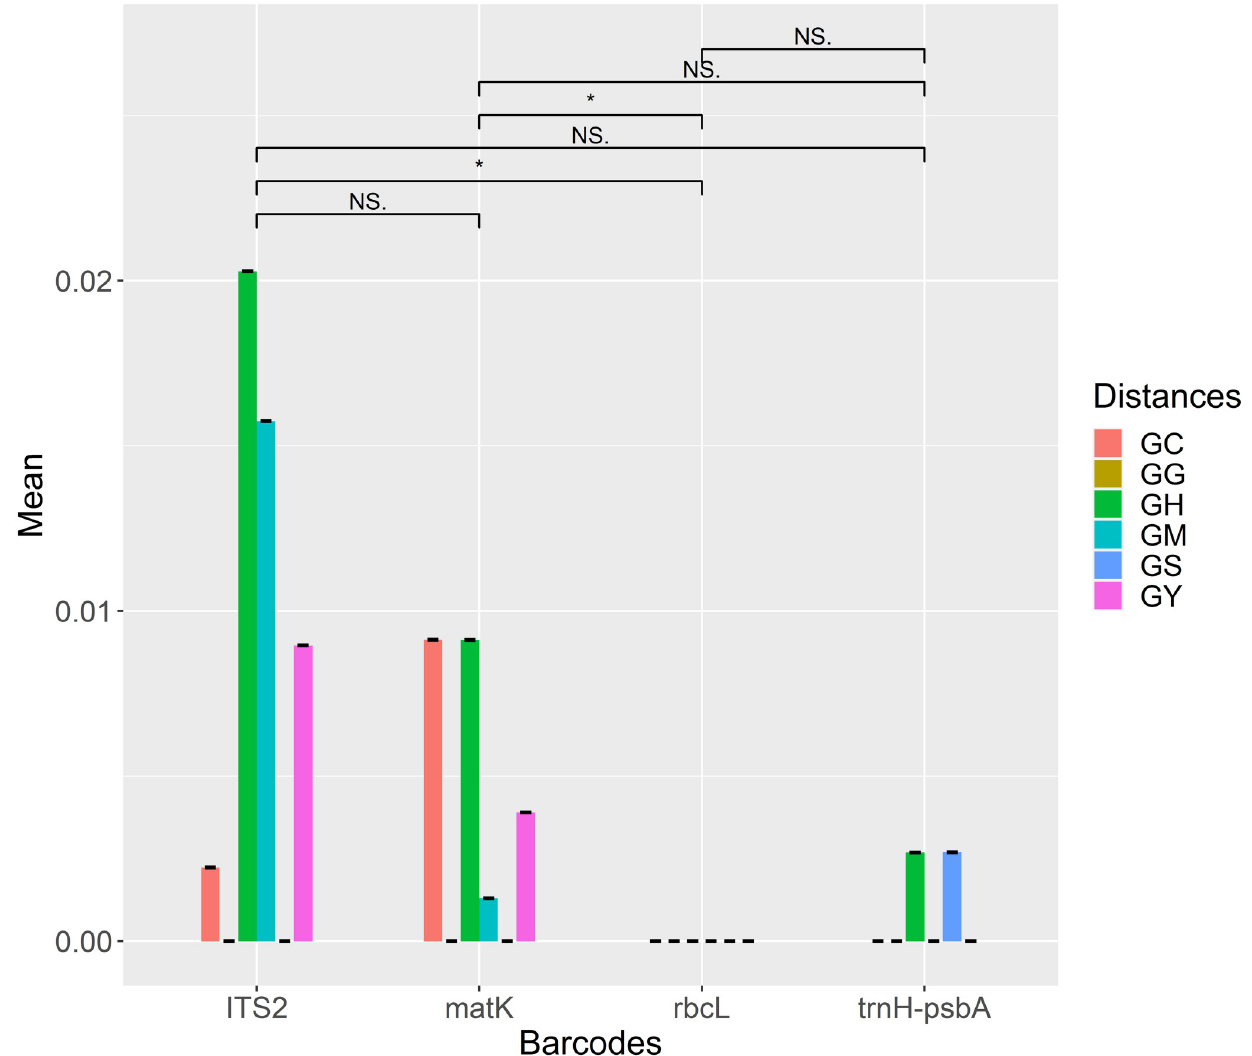
Fig 3. Genetic distances between 58 Qi-Nan germplasms and the Aquilaria species for a single region. ( GC : interspecific distance between the Qi-Nan germplasm and A . crassna . GG : intraspecific distance among the Qi-Nan germplasms. GH : interspecific distance between the Qi-Nan germplasm and A . hirta . GM : interspecific distance between the Qi-Nan germplasm and A . malaccensis . GS : interspecific distance between the Qi-Nan germplasm and A . sinensis . GY : interspecific distance between the Qi-Nan germplasm and A . yunnanensis . � : P < 0.05, NS: not significant).